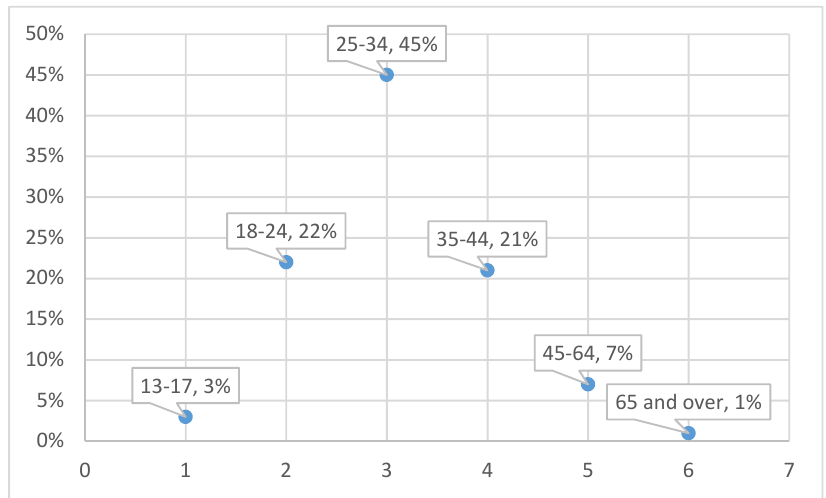
Figure 5. Age groups of Realfooders.